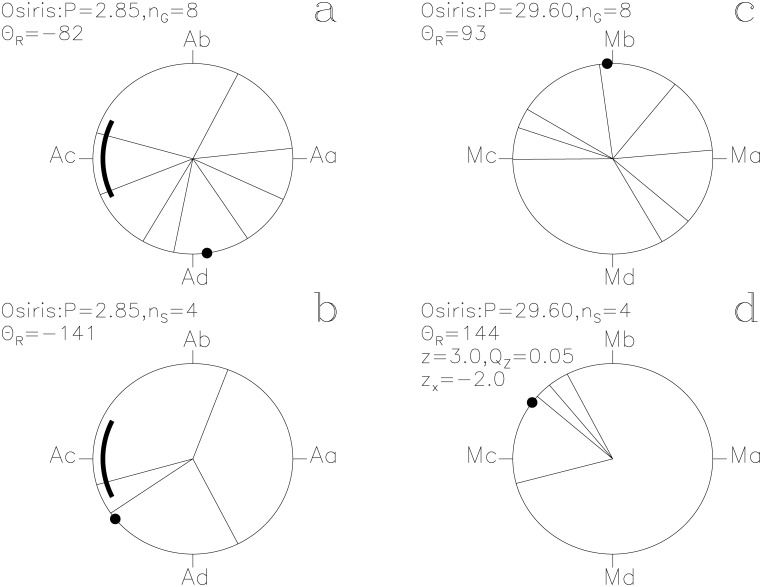
Osiris.otherwise as in Fig 1